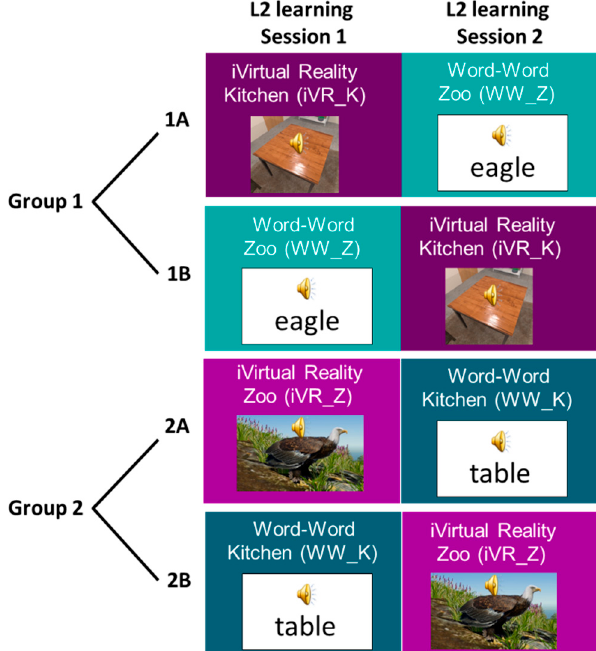
Figure 1. Overview of L2 learning conditions. All participants learned the same 30 kitchen items and 30 zoo items, and all learned 30 words in an immersive virtual reality (iVR) condition and 30 words in a word–word (WW) paired association condition through a counterbalanced design. Participants in Group 1 learned via iVR Kitchen and WW Zoo, with Group 1A learning iVR Kitchen items first and Group 1B learning WW Zoo items first. Participants in Group 2 learned via iVR Zoo and WW Kitchen, with Group 2A learning iVR Zoo items first and Group 2B learning WW Kitchen items